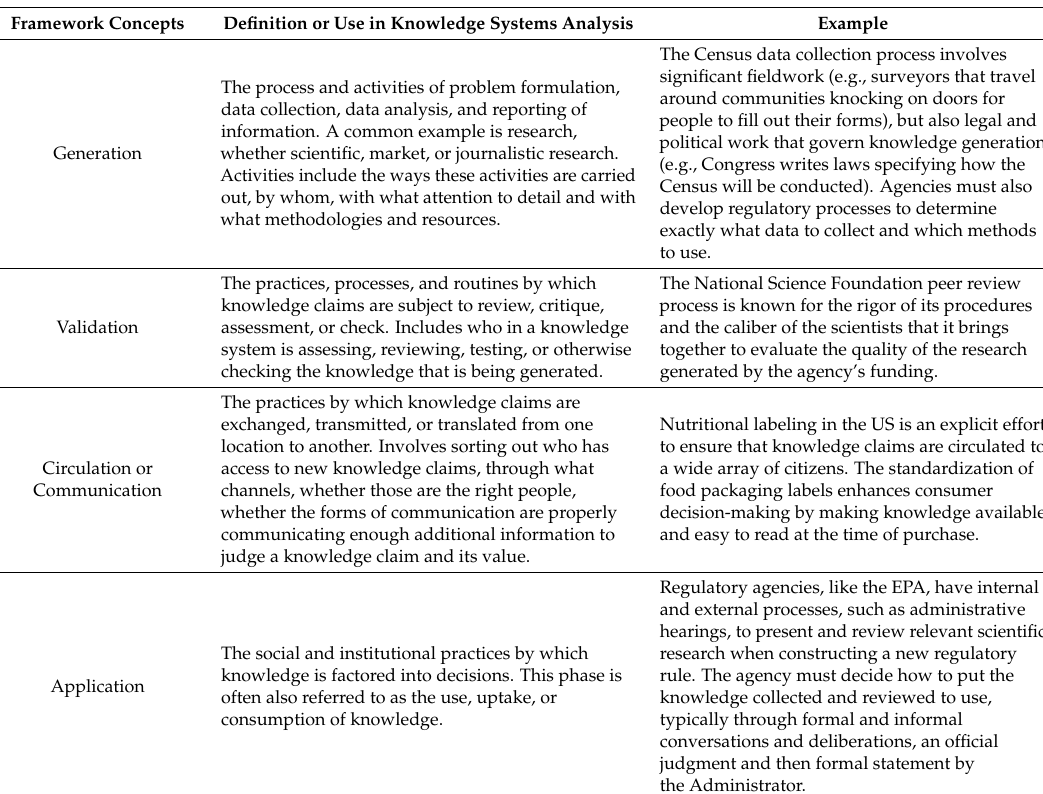
Table 2. Functions of knowledge